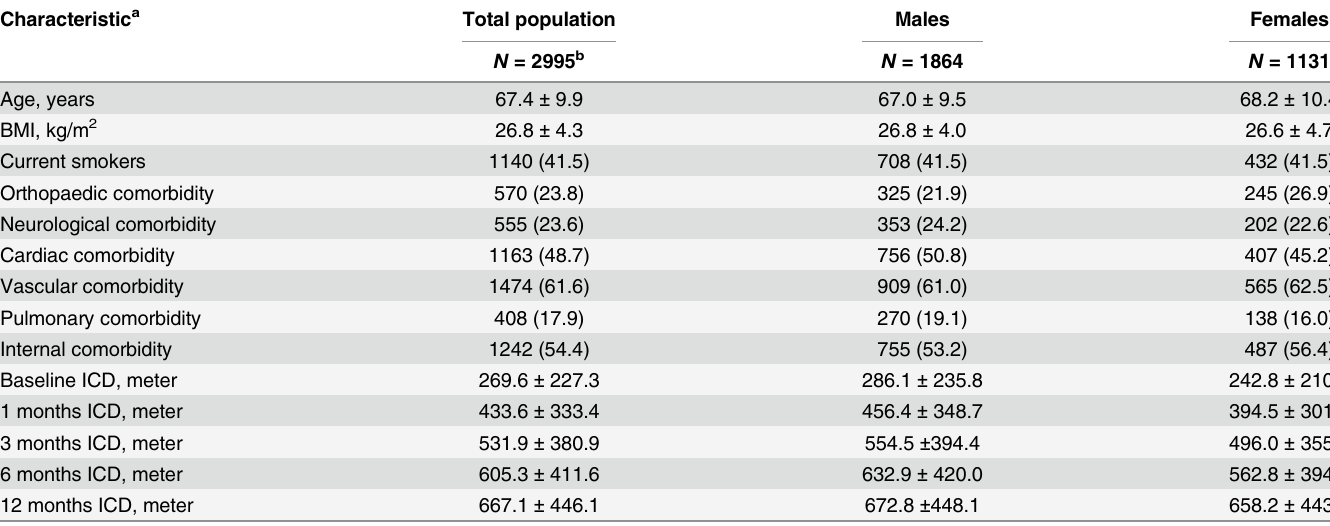
Table 1. Characteristics of the study population.